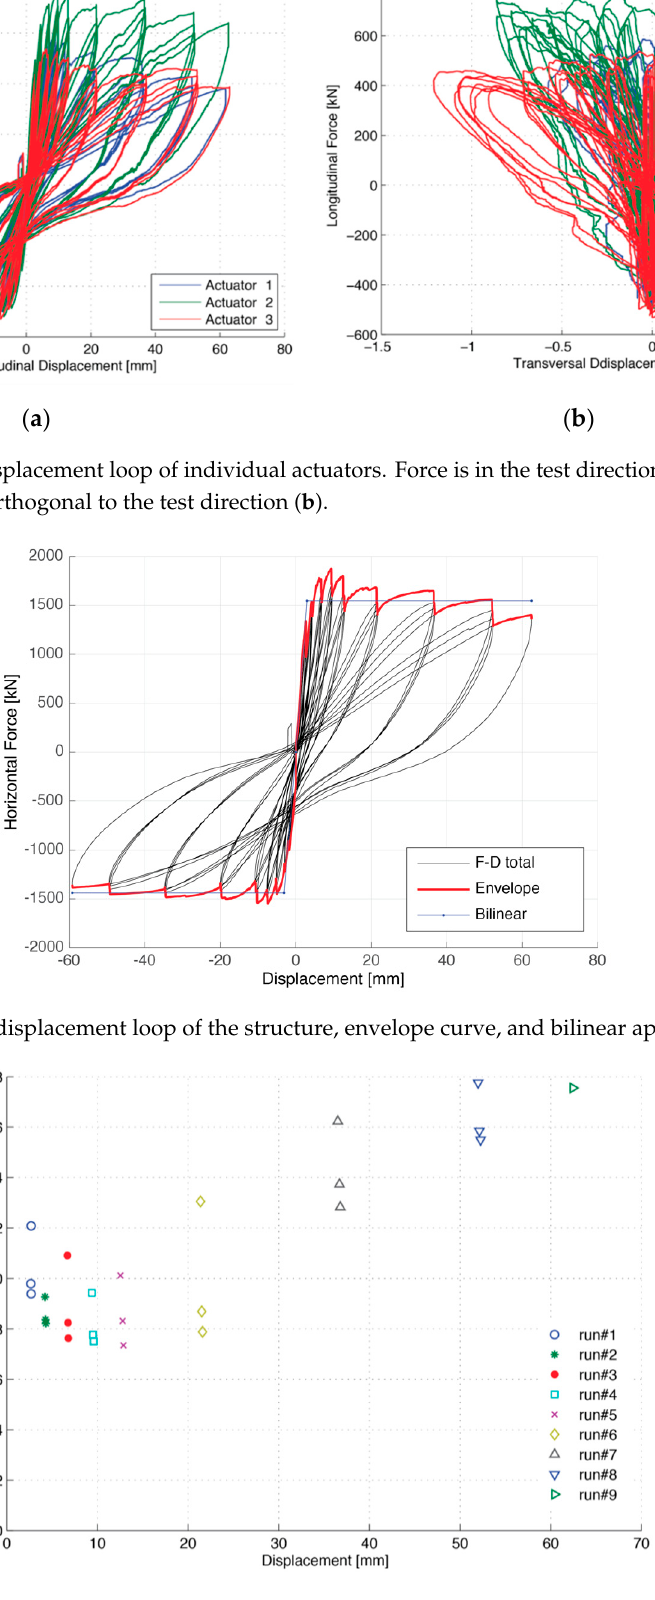
Figure 24. Equivalent viscous damping for the three cycles of each run.